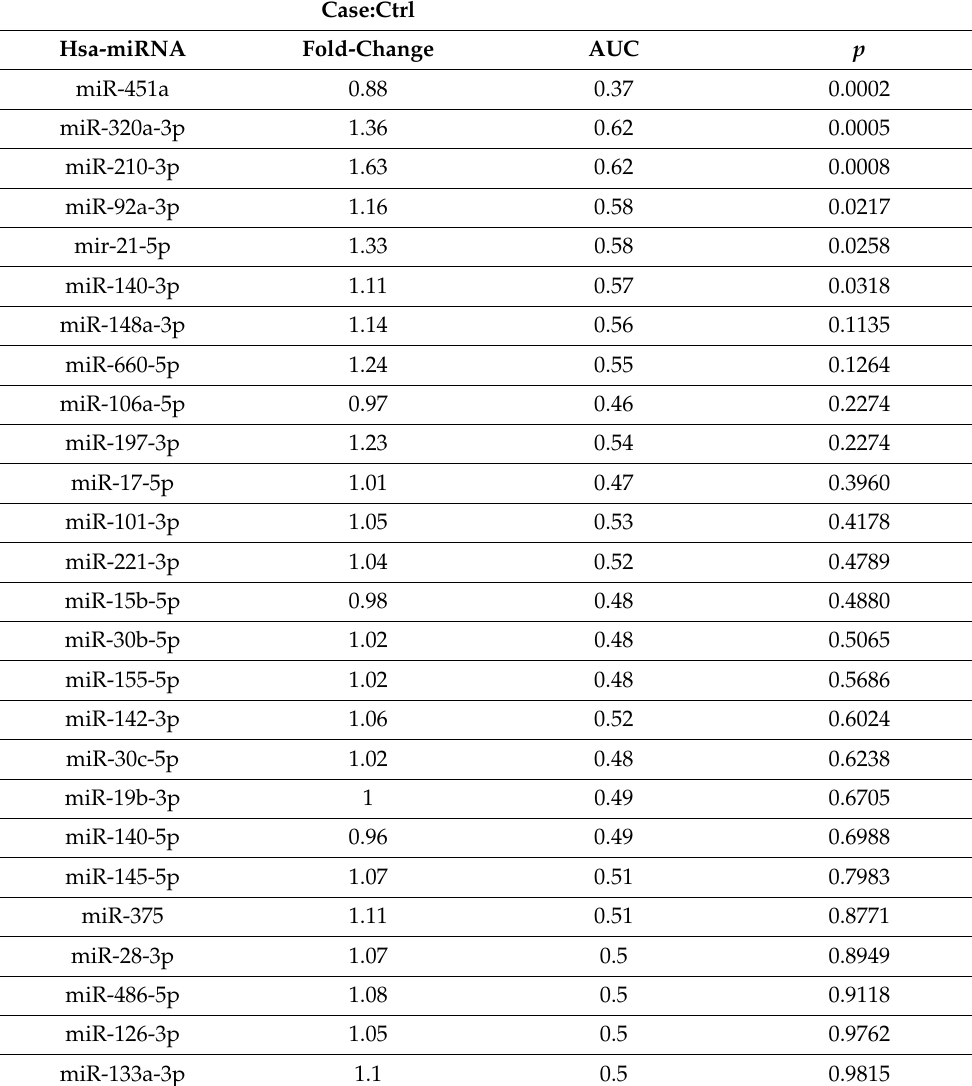
Table 3. Performance of miRNAs for distinguishing lung cancer cases diagnosed within one year following blood draw from matched controls. AUC, Area Under the Receiver Operating Characteristic curve; Ctrl,